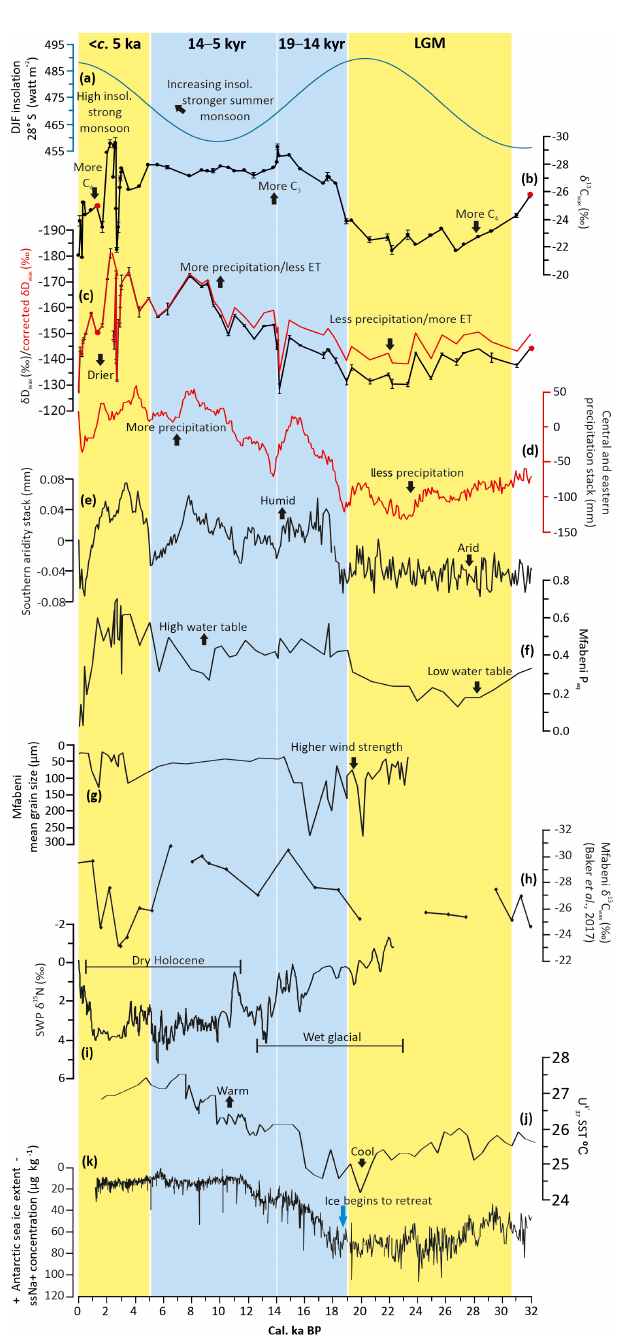
Figure 4. Climate and environmental change at Mfabeni compared with regional records and orbital insolation. (a) December–January– February (DJF) insolation for 28 ◦ S (blue line; Laskar et al., 2011). (b) Stable carbon isotope composition (weighted mean) of C 29 –C 31 n -alkanes from Mfabeni, reflecting changes in C 3 / C 4 vegetation type. (c) Hydrogen isotope composition (weighted mean) of C 29 –C 31 n - alkanes from Mfabeni, reflecting changes in precipitation amount and ET. Red is the δ D wax corrected for ice volume changes. Error bars on isotope data reflect analytical uncertainty of duplicate analyses. (d) Central and eastern South African regional precipitation stack (red line; Chevalier and Chase, 2015). (e) Southern African regional aridity stack (Chevalier and Chase, 2016). (f) P aq at Mfabeni, indicating the amount of aquatic vs. terrestrial n -alkanes (high/low water table). (g) Mean grain size data of the lithogenic sediment fraction from Mfabeni (Humphries et al., 2017). (h) Mfabeni core SL6 stable carbon isotope composition (weighted mean) of C 29 –C 31 n -alkanes (Baker et al., 2017). (i) Combined nitrogen isotope data from Seweweekspoort rock hyrax middens, reflecting changes in humidity (Chase et al., 2017). (j) U K (cid:48) -derived SSTs from core MD79257 in the Mozambique Channel (Sonzogni et al., 1998). (k) Sea-salt sodium concentrations from the 37 EPICA DML ice core in Antarctica, reflecting changes in sea-ice coverage (Fischer et al., 2007). The two Mfabeni samples with CPI values of ca. 2 are highlighted in red (b, c) . Blue shading: Mfabeni wet, orange: Mfabeni arid. Clim. Past, 15, 1153–1170,